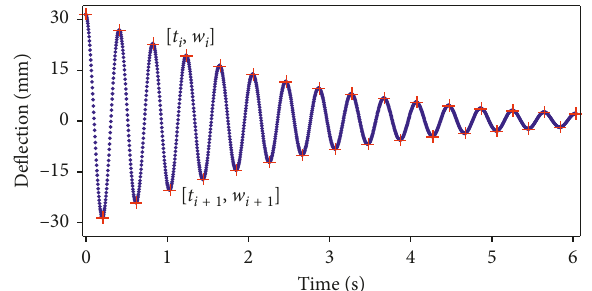
Figure 8: Vibrations measured by sensor S tremes; MRE 1B, magnet M8,